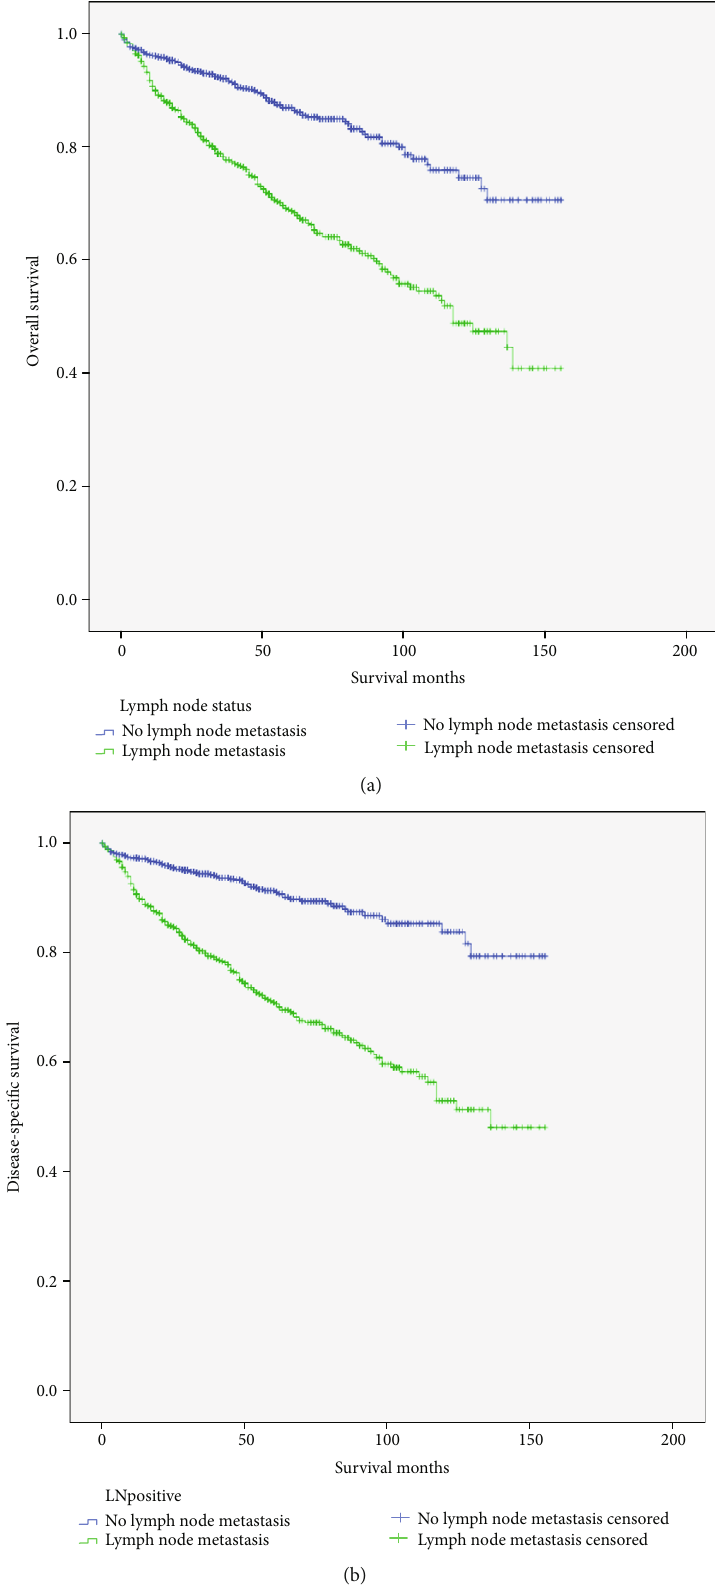
Figure 2: The Kaplan-Meier curve depicting the overall survival (a) and disease-speci fi c survival (b) of patients with and without lymph node